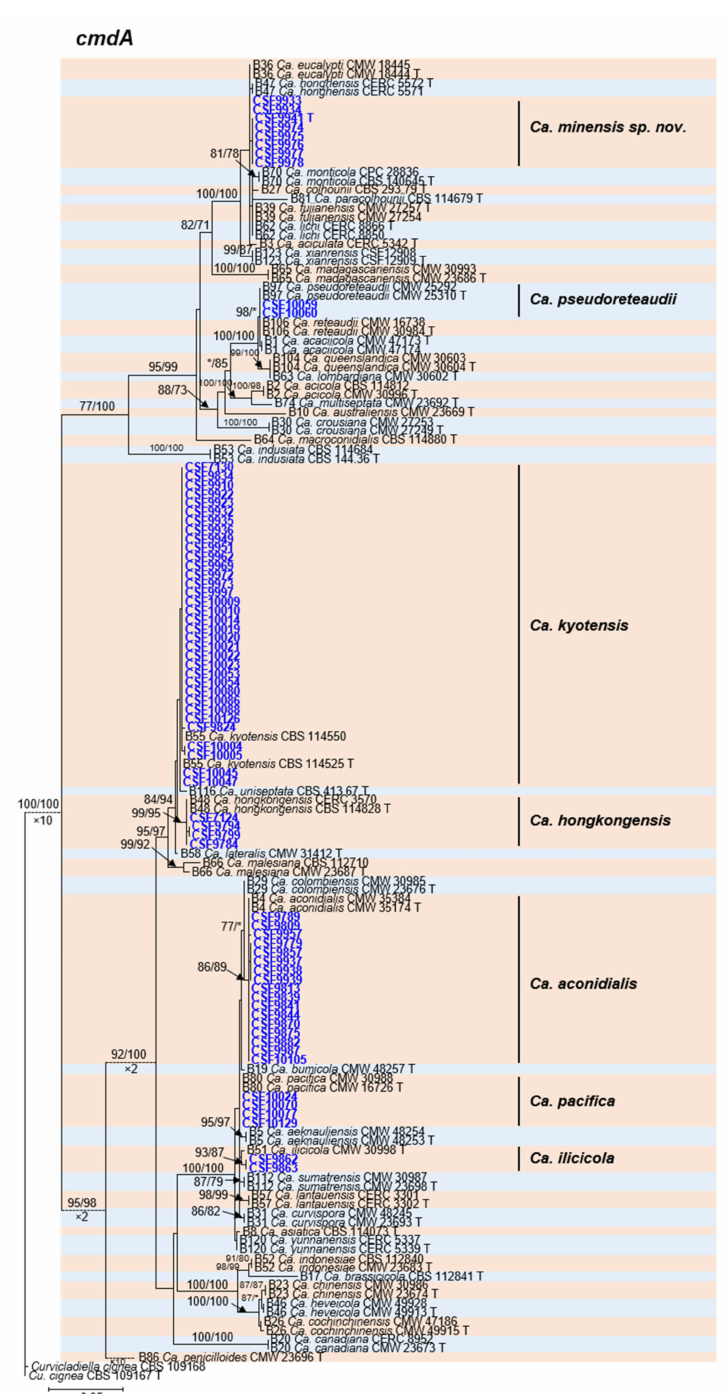
Figure A2. Phylogenetic tree of Calonectria species based on maximum likelihood (ML) analyses of cmdA gene sequences. Bootstrap value ≥ 70% for ML and MP analyses are presented at the branches. Bootstrap values lower than 70% are marked with “*”, and absent analyses values are marked with “-”. Ex-type isolates are marked with “T”. Isolates sequenced in this study are highlighted in blue and bold type. The “B” species codes are consistent with the recently published results in Liu and co-authors [18]. The tree was rooted to Curvicladiella cignea (CBS 109167 and CBS